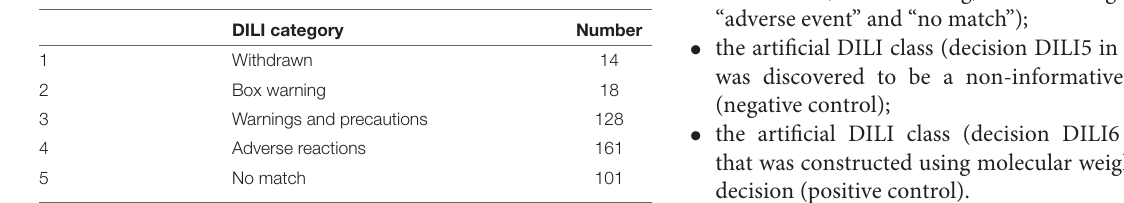
TABLE 2 | Number of objects in DILI4